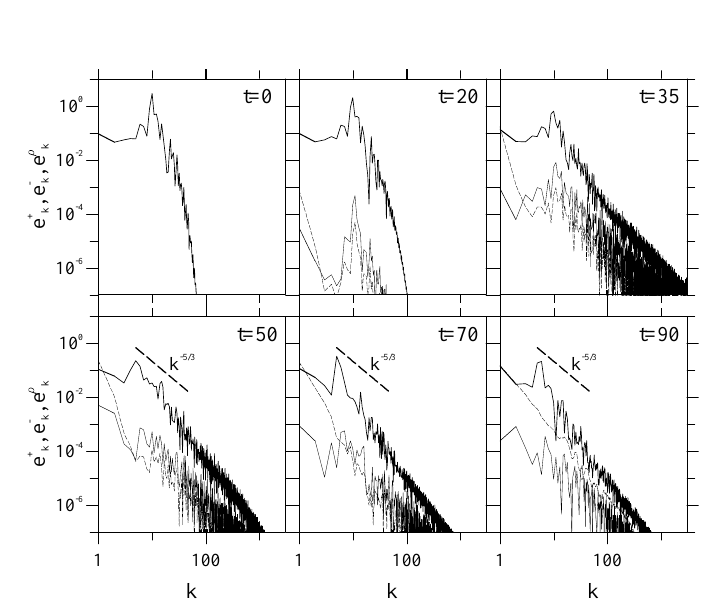
Figure 69: Spectra of e + (thick line), e – (dashed line), and 𝑒 𝜌 (thin line) are shown for 6 different times during the development of the instability. For 𝑡 ≥ 50 a typical Kolmogorov slope appears. These results refer to 𝛽 = 1. Image reproduced by permission from Malara et al. (2001b), copyright by EGU.